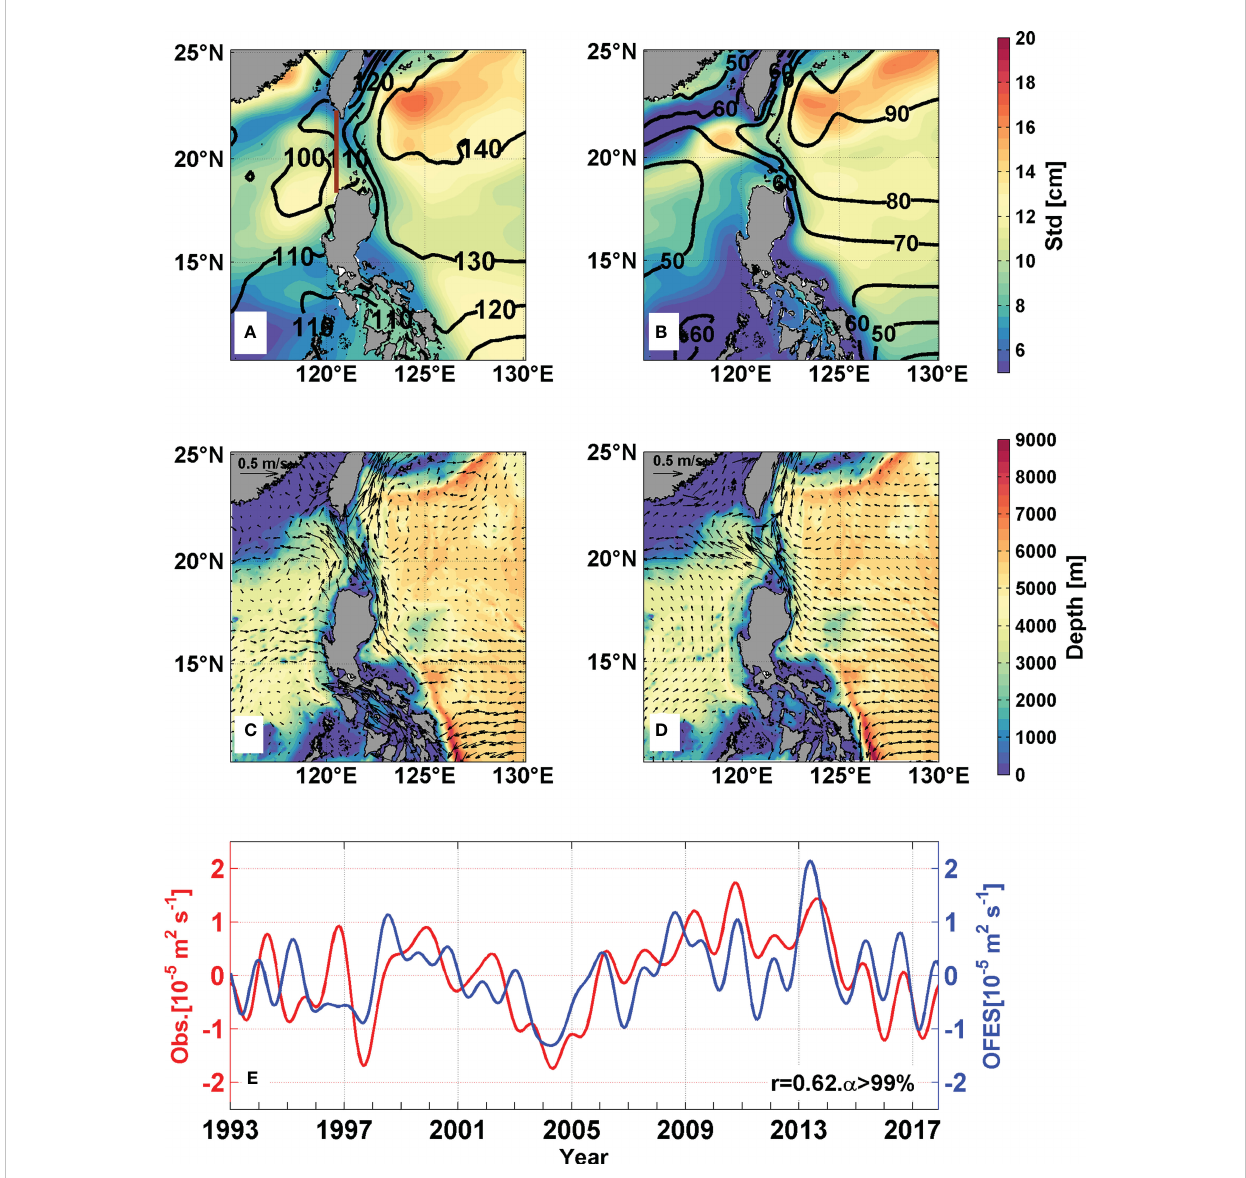
FIGURE 1 Standard deviation of SSH (shaded in cm) and SSH (contours in 10 cm intervals) calculated from (A) CMEMS and (B) OFES outputs, respectively. The climatology of the observed sea surface current (unit: m s -1 ) calculated with (C) satellite data from CMEMS and (D) OFES outputs. (E) Time series (13- month low-pass fi lter) of Luzon Strait transport (unit: 10 -5 m 2 s -1 ) in the upper 10 m layer from CMEMS (red line) and OFES (blue line) data. The dark red line in Figure 1A indicates the geostrophic location of the Luzon Strait at